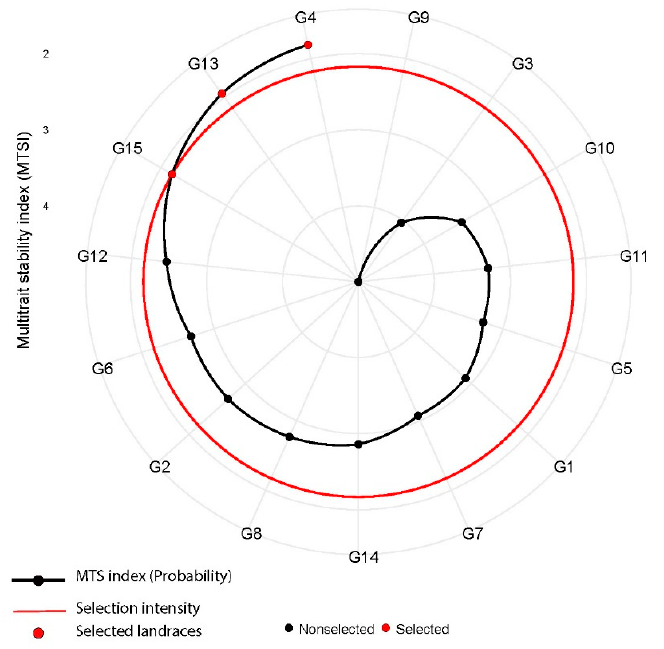
Figure 6. Landrace ranking based on the MTSI considering a selection intensity of 20 percent red circle. Selected landraces are highlighted in red. 2, 3, and 4 indicate the multi-trait stability index.